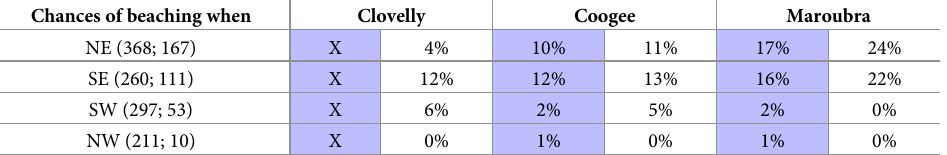
Table 3. Frequency of beaching events per wind sector. The 4 sectors: North-East (NE), South-East (SE), South-West (SW) and North-West (NW) are redefined following the orientation of the coastline (see windrose of Fig 1). Blue: com- puted on data 24 hours before a sighting, all year round from 2016–2020, black: on summer dates only from 2016– 2020. The number of days for each wind sector is indicated in bracket (all year; summer only). Chances of beaching